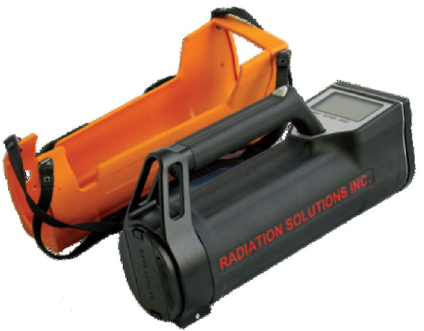
Figure 2. In-situ equipment RS-125 with the following specifications: Large NaI(Tl) crystal: 5 × 5 cm (2 × 2 in.), 1024 Channel spectrometer and Energy Range of 30–3000